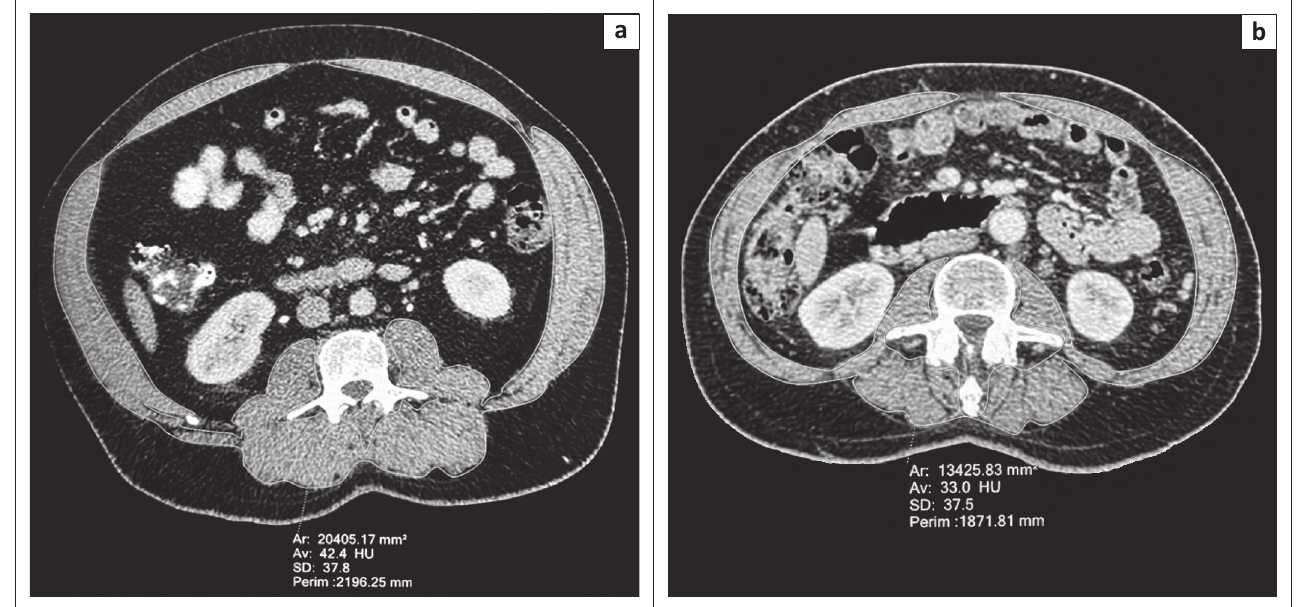
FIGURE 1: Two CTs (axial slices at L3 level) demonstrating the measurement of cross-sectional muscle area at L3 level (CSMA L3) (a) 54-year-old male with a BMI of 32.6 kg/m 2 with no sarcopenia: CSMA L3 204.1 cm 2 , L3 skeletal muscle index (SMI L3) 73.2 cm 2 /m 2 and (b) 63-year-old male with a BMI of 26.0 kg/m 2 with sarcopenia: CSMA L3 134.3 cm 2 , SMI L3 45.4 cm 2 /m 2